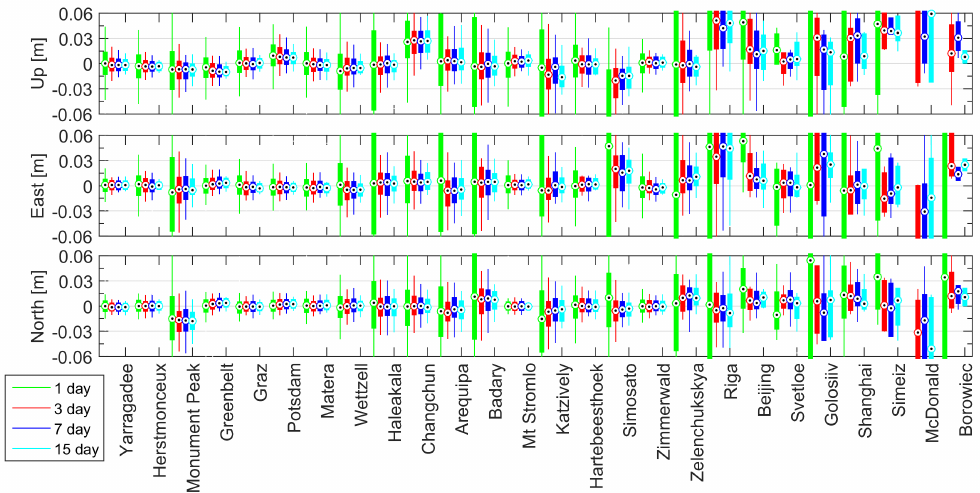
Figure 8. Coordinate comparison to SLR2014 results from S3A/B when using different numbers of 1-day normal equations: 1-day (green), 3-day (red), 7-day (blue), 15-day (cyan). Minimum, maximum, 1st and 3rd quartiles and the median value are shown as elements of box-plots. Stations are sorted according to the number of 7-day solutions, starting with the highest number ( left ) to the lowest number of solutions ( right